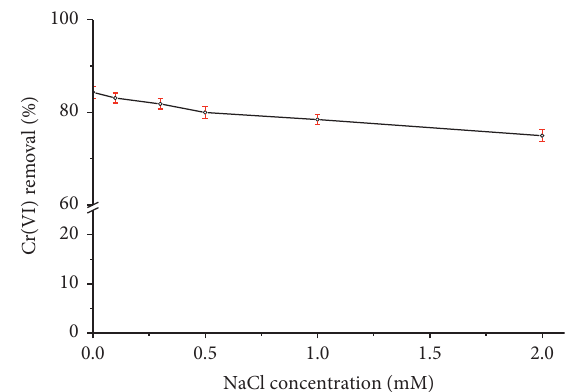
Figure 7: Effect of ionic strength on removal of Cr(VI) using organobentonite. Conditions: C i � 50mg/L, V � 50mL, T � 20 ° C, pH � 3.0, stirring speed � 200 rpm, HDTMA-Bent � 0.2g, and contact time �